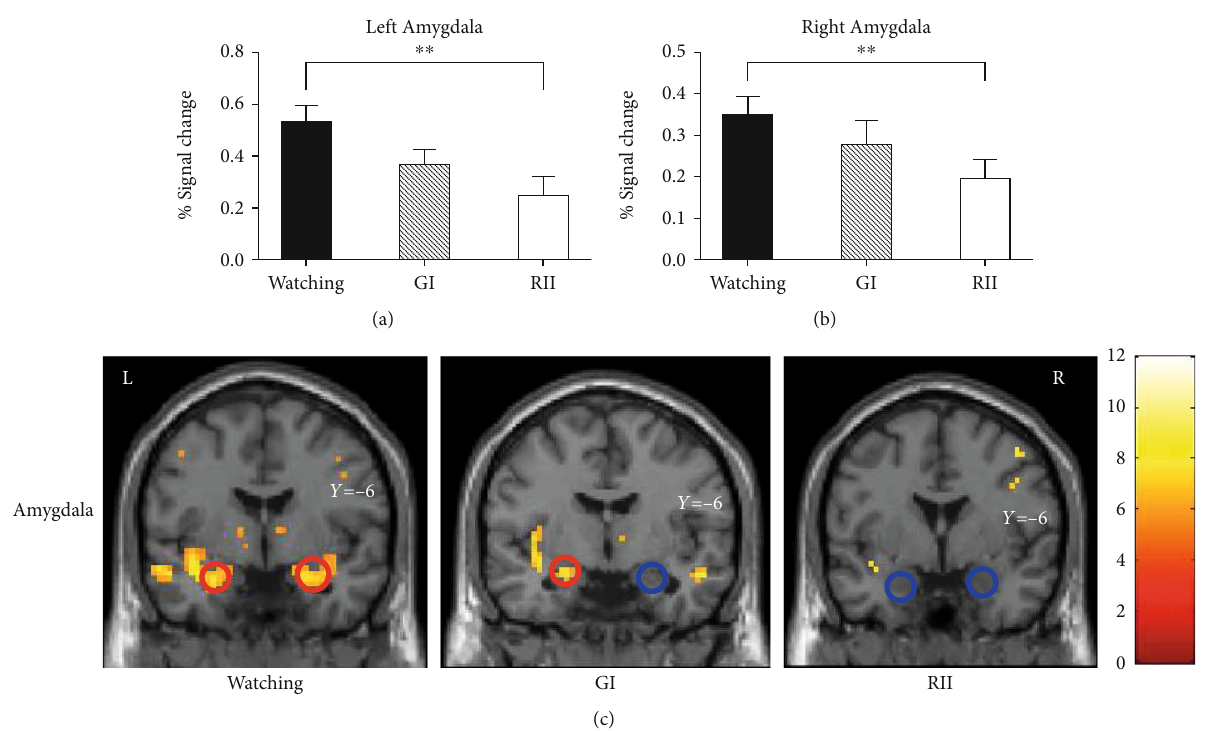
Figure 3: The emotion-regulatory e ff ects of RII in the (a) left and (b) right amygdala ROIs. The intensity of negative a ff ect during each condition was represented by the BOLD signal changes of the negative block versus the neutral block. (c) An illustration of amygdala activation among watching, GI, and RII conditions (FWE corrected p = : 01 and an extent of 10 voxels). Error bars = SEM ; ∗∗ means p < 0 : 01